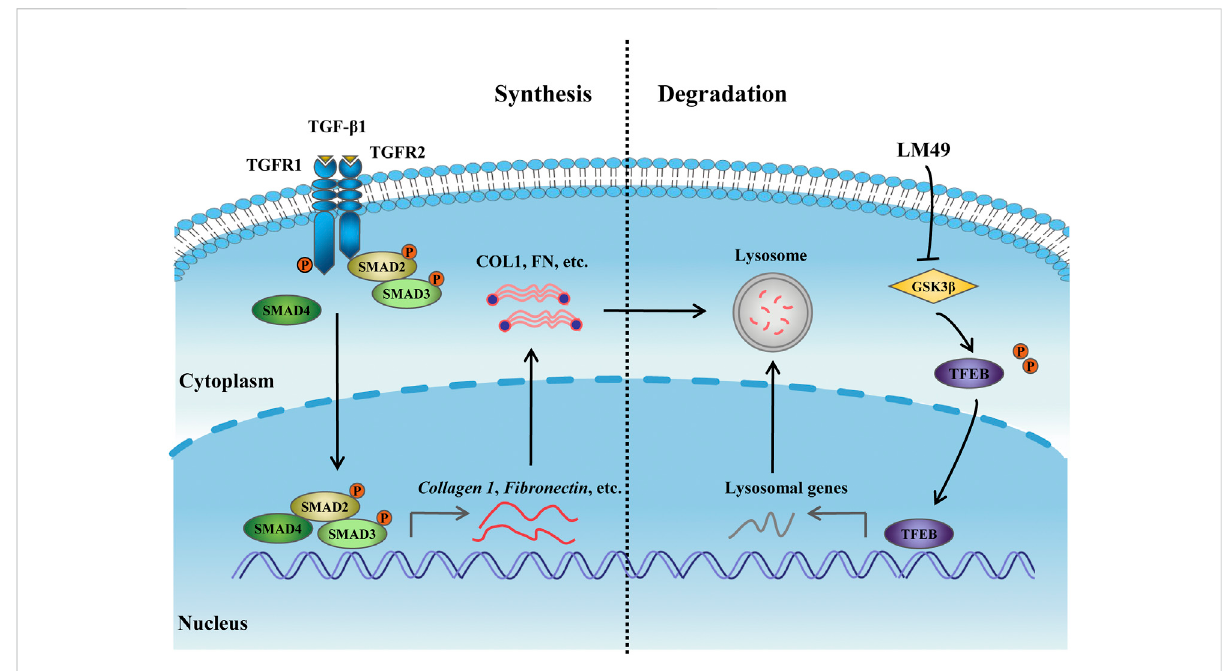
FIGURE 8 The mechanism of LM49-activated lysosome biogenesis involves directly inhibiting GSK3 β to trigger ECM